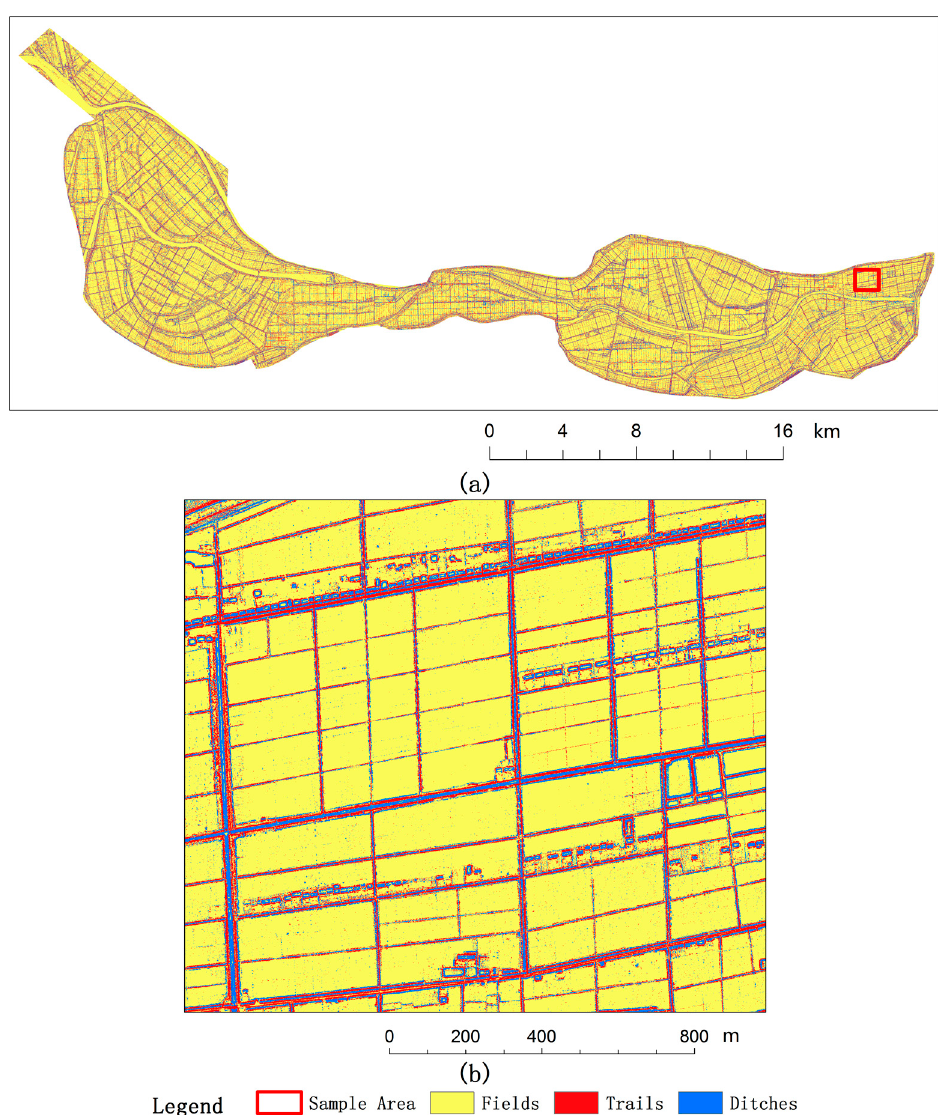
Figure 9. Raster results of the research area: ( a ) entire area, and ( b ) sample area.